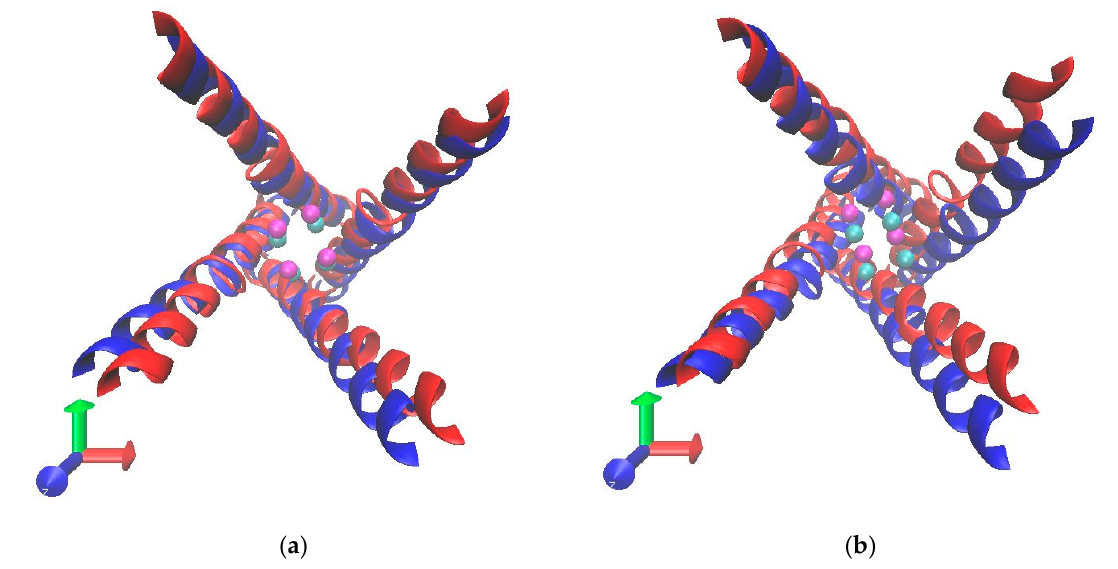
Figure 4. A top view of the gate of TRPV1 membrane-embedded models at normal (blue) and elevated pressure levels (red) at ( a ) 47.5 and ( b ) 100 ns timeframe. Only S6 domains (residues from 659-689) are shown as a ribbon diagram. The lower gate (I679), shown as beads, is colored in cyan and magenta at normal and elevated pressures, respectively.